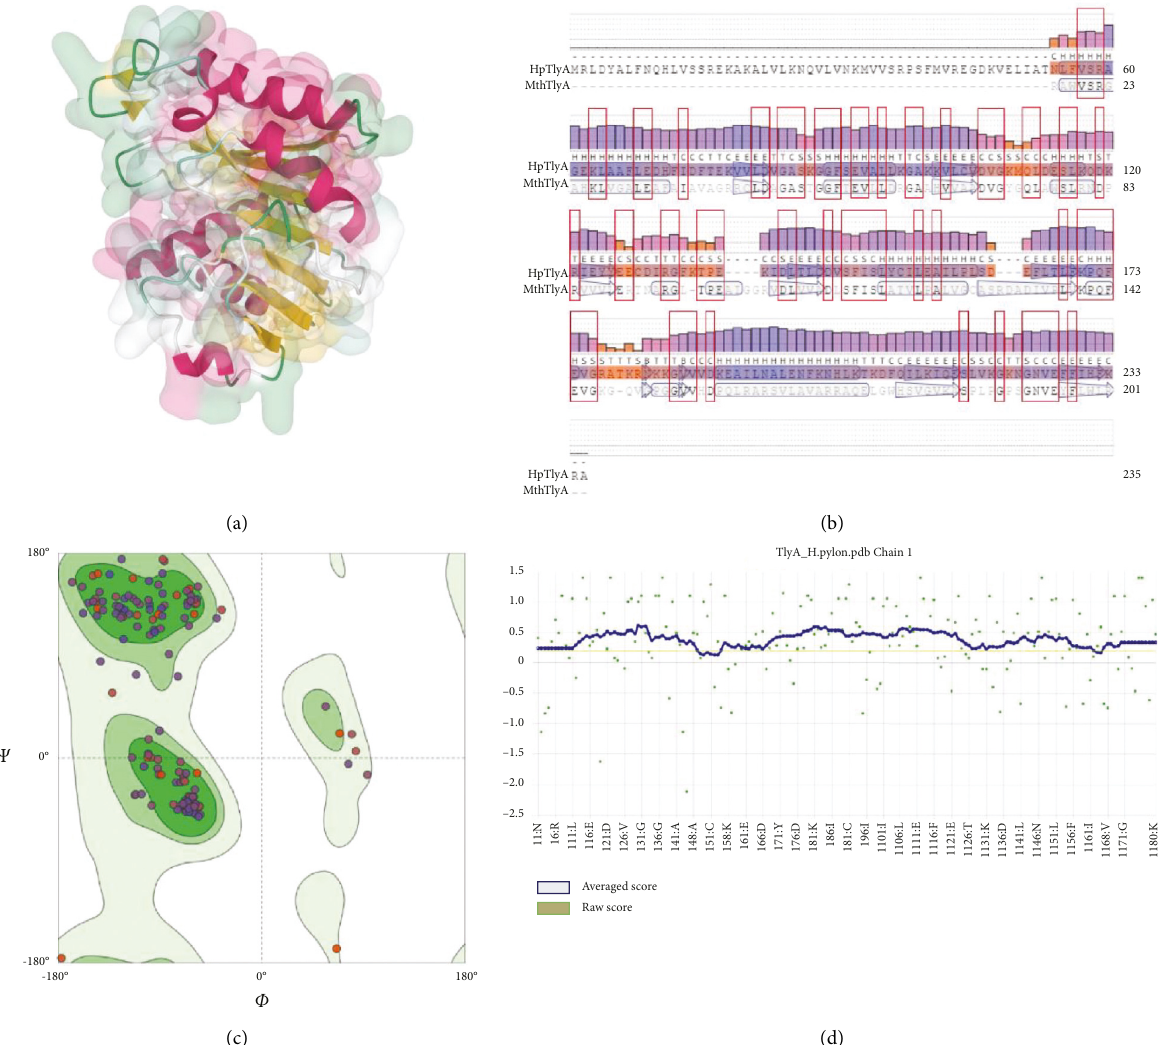
Figure 1: The predicted three-dimensional structures of HpTlyA. (a) 3D structure of HpTlyA. (b) Residue quality. (c) Ramachandran Plots. (d) 3D verification by